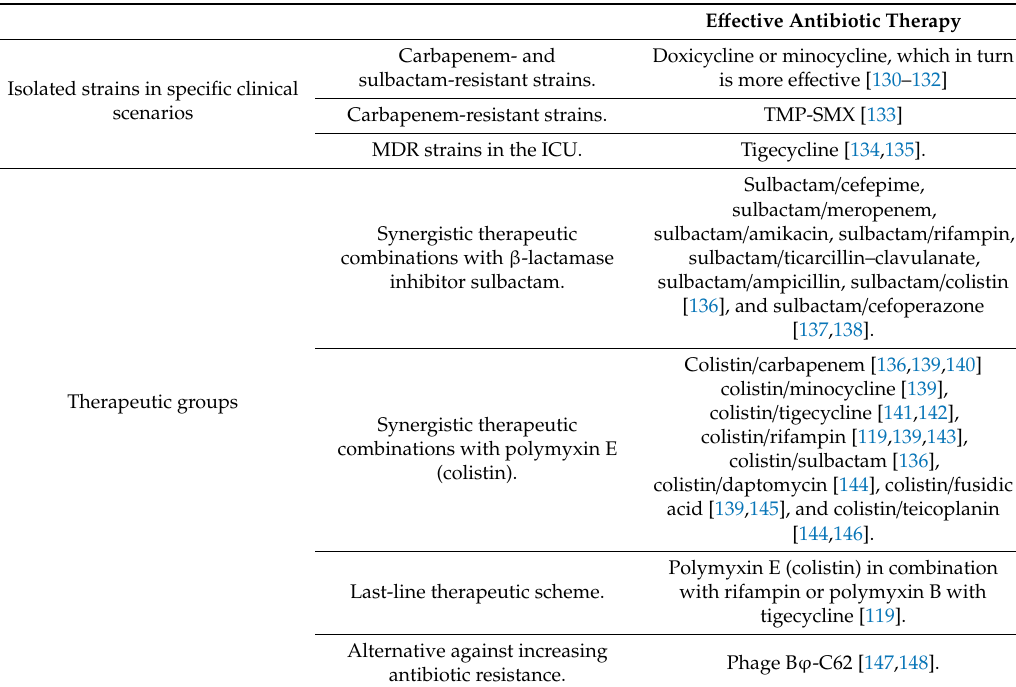
Table 1. E ff ective Antibiotic Therapies against A . Baumannii according to Therapeutic Groups and Isolated Strains in Specific Clinical